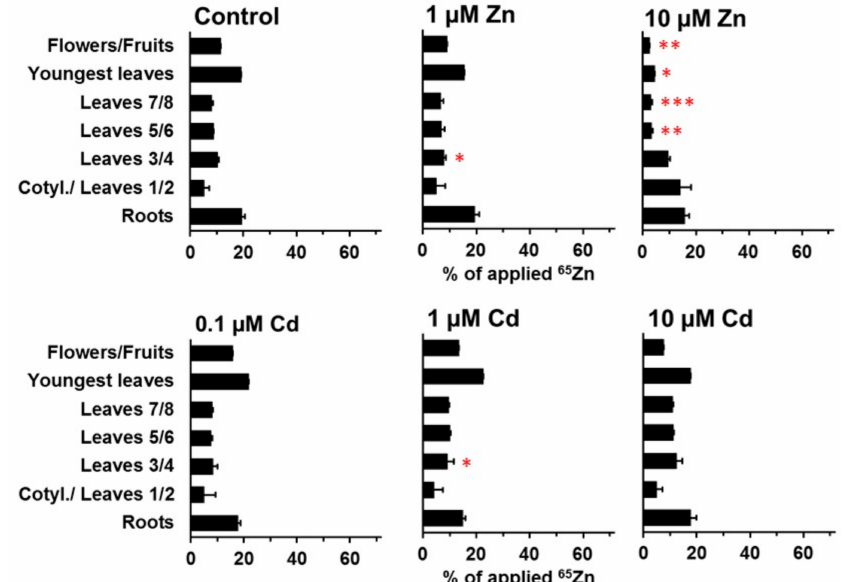
Figure 8. Redistribution of 65 Zn in plants grown on standard nutrient medium (Control) or on the same medium with increased Zn (1 µ M Zn and 10 µ M Zn) or Cd (0.1 µ M Cd, 1 µ M Cd, and 10 µ M Cd) concentrations for 21 d after the labeling phase (duration: 3 d). Means + SE of four replicates are shown. Significantly higher (*, **, ***) and lower (*, **, ***) values than in control plants on the P = 0.05 (*, *), P = 0.01 (**, **), and P = 0.001 (***, ***) level are indicated (Student’s